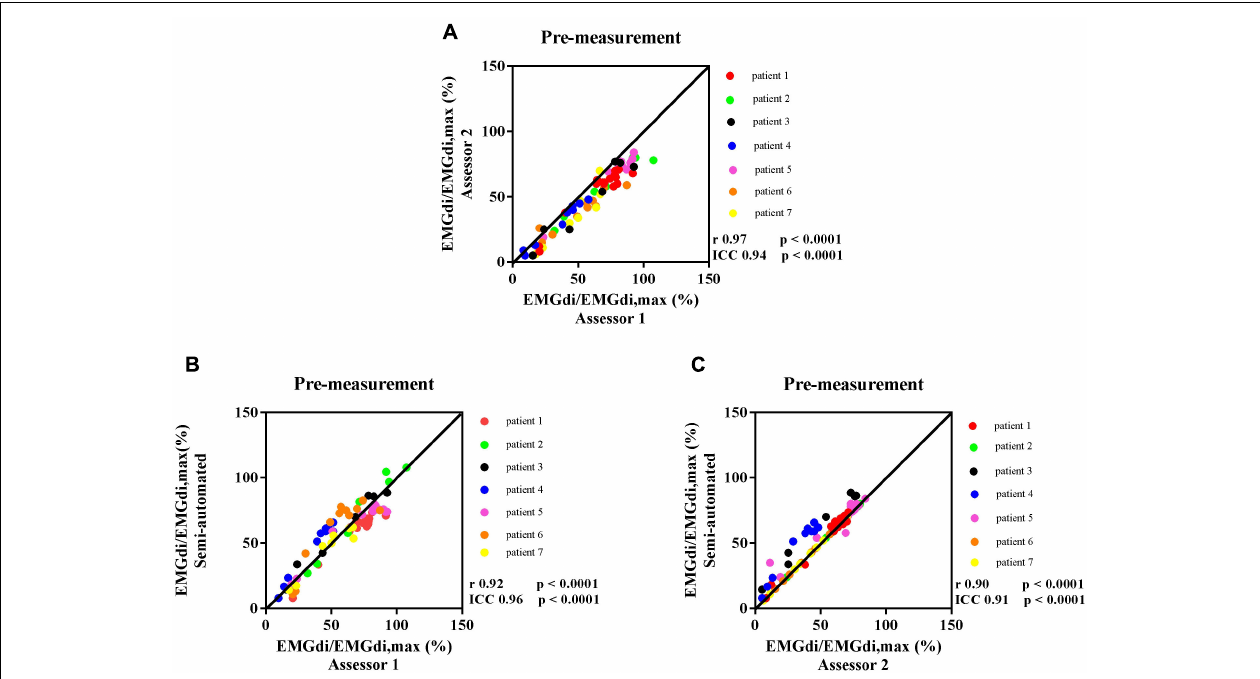
FIGURE 4 | The correlation between EMGdi/EMGdiMax% calculated from the manual method by two assessors during the pre-measurement CWR cycling test (A) ; the semi-automated method and the manual method by assessor 1 (B) ; and the semi-automated method and the manual method by assessor 2 (C) . Line of identity, linear regression coefficients, intra-class correlation coefficients (ICC), and significances are presented in each figure. Each of the data points represents the activation of diaphragm EMG (EMGdi/EMGdiMax%) of each patient in every minute during the pre-measurement CWR cycling